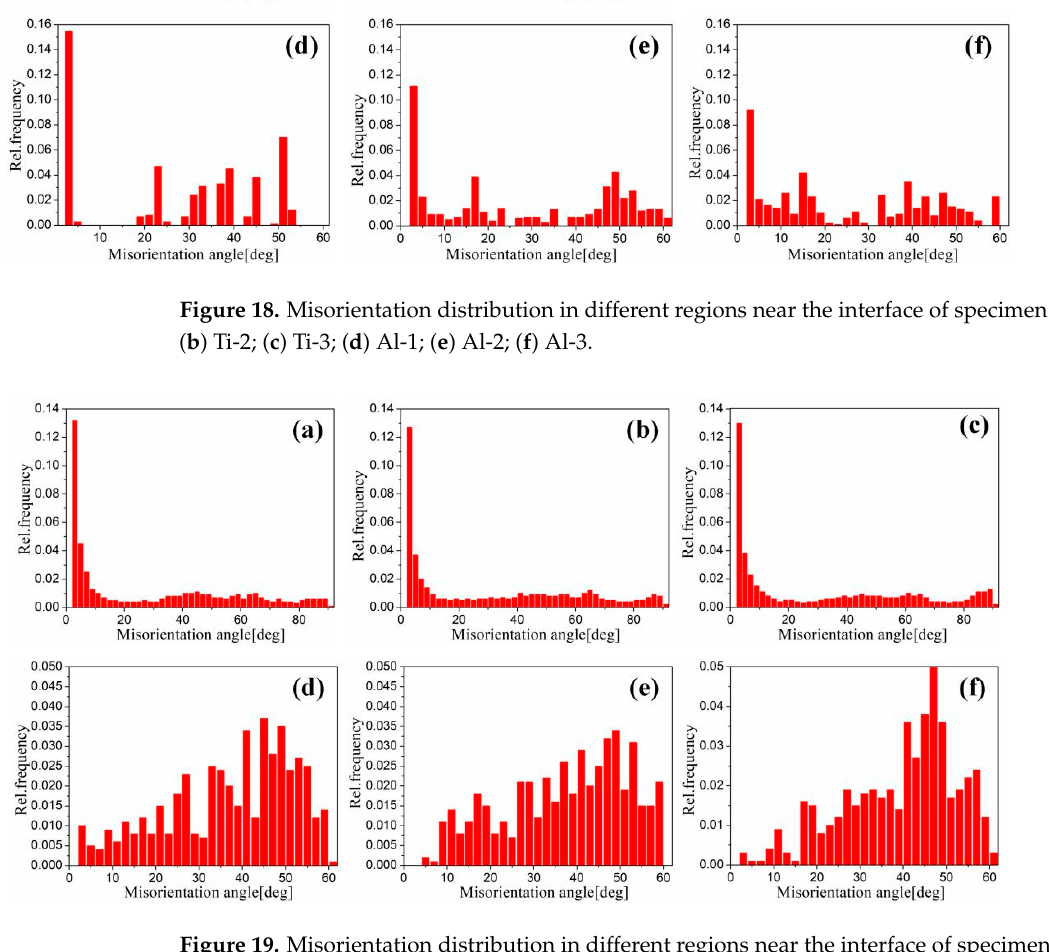
_ _ _ 0> boundaries, 85° <1 21 0> boundaries and 45° <51